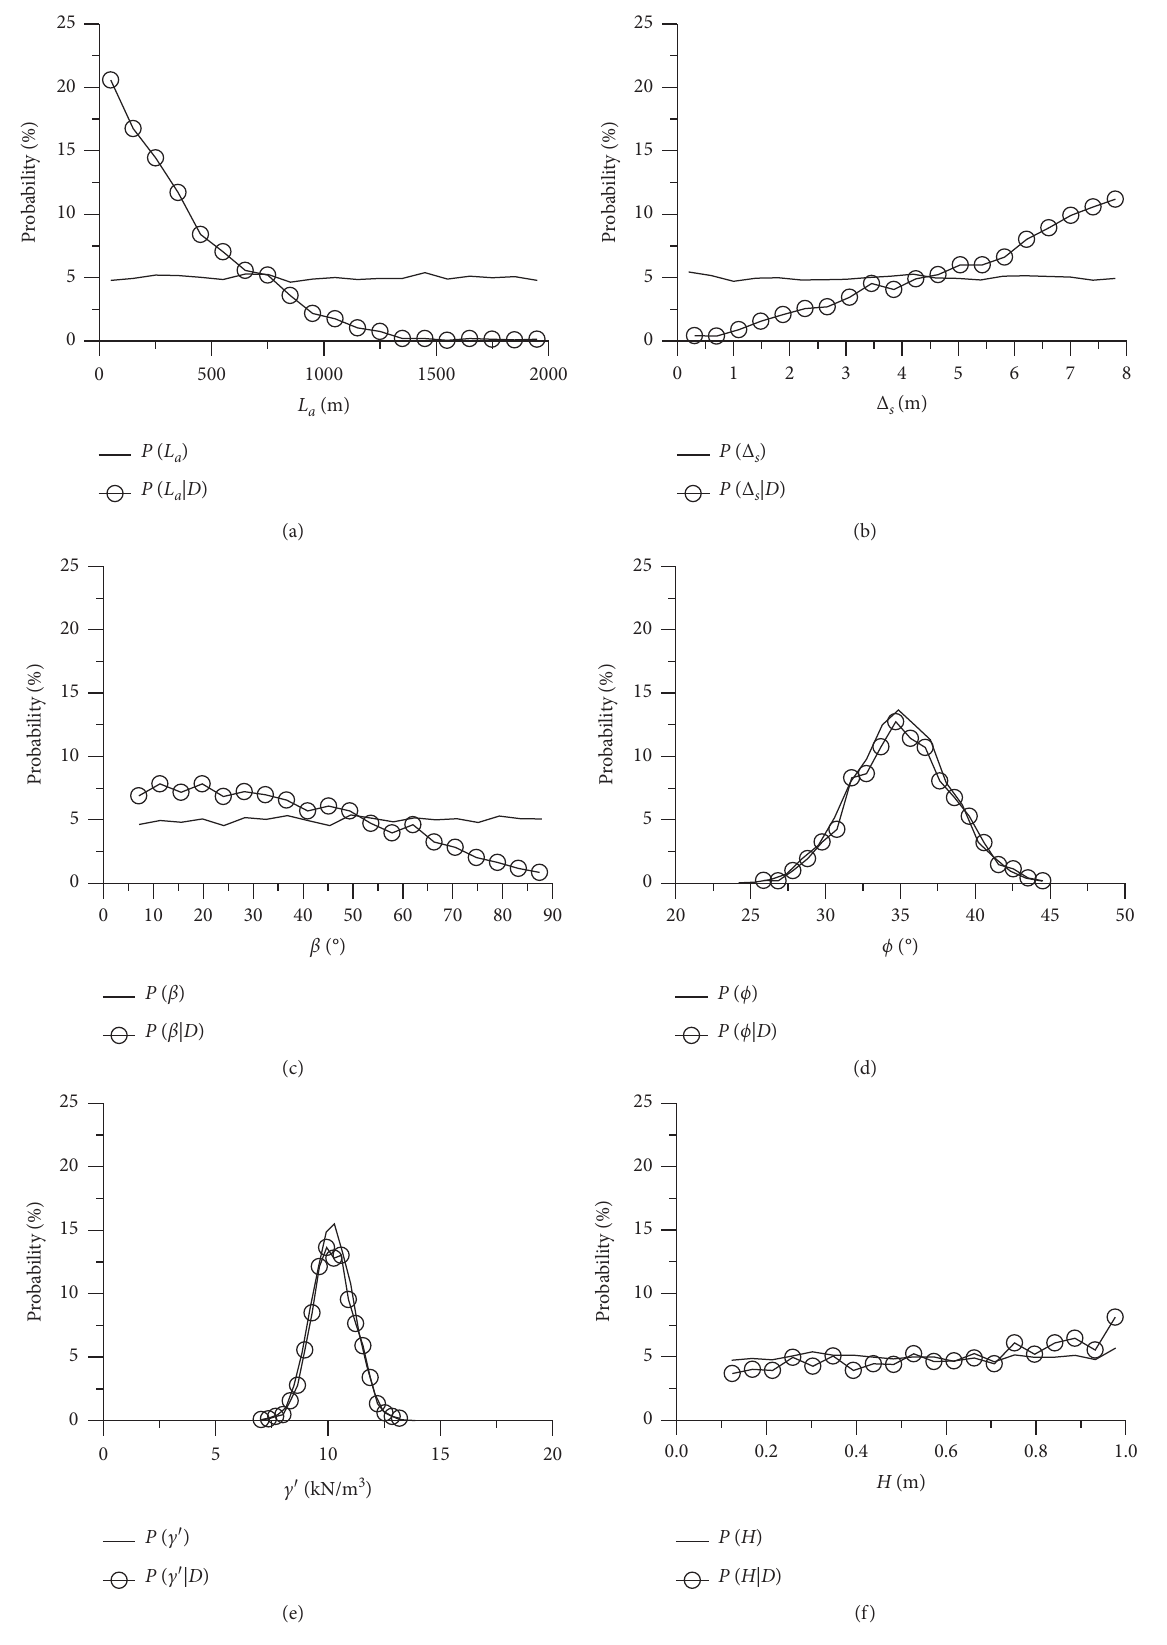
� seabed offset, ∆ s ; (c) θ � intersection a ; (b) θ